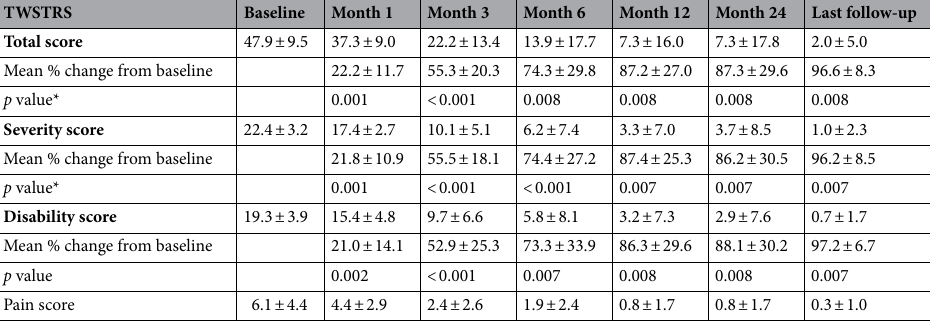
onset, p = 0.513; duration of disease, p = 0.558; age at surgery, p = 0.507; duration of stimulation, p = 0.332; base- line TWSTRS severity, p = 0.206). Stimulation parameters. The stimulation parameters were shown in Table 2. Post-operative imaging con- firmed all of electrodes were implanted near the predetermined location (central in the dorsal STN). A total of 18 DBS electrodes were placed in 9 patients and all used monopolar stimulus mode. At the last follow-up visit,